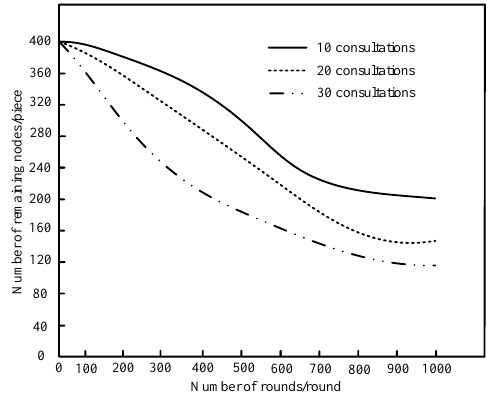
Figure 9. Waveform of abnormal